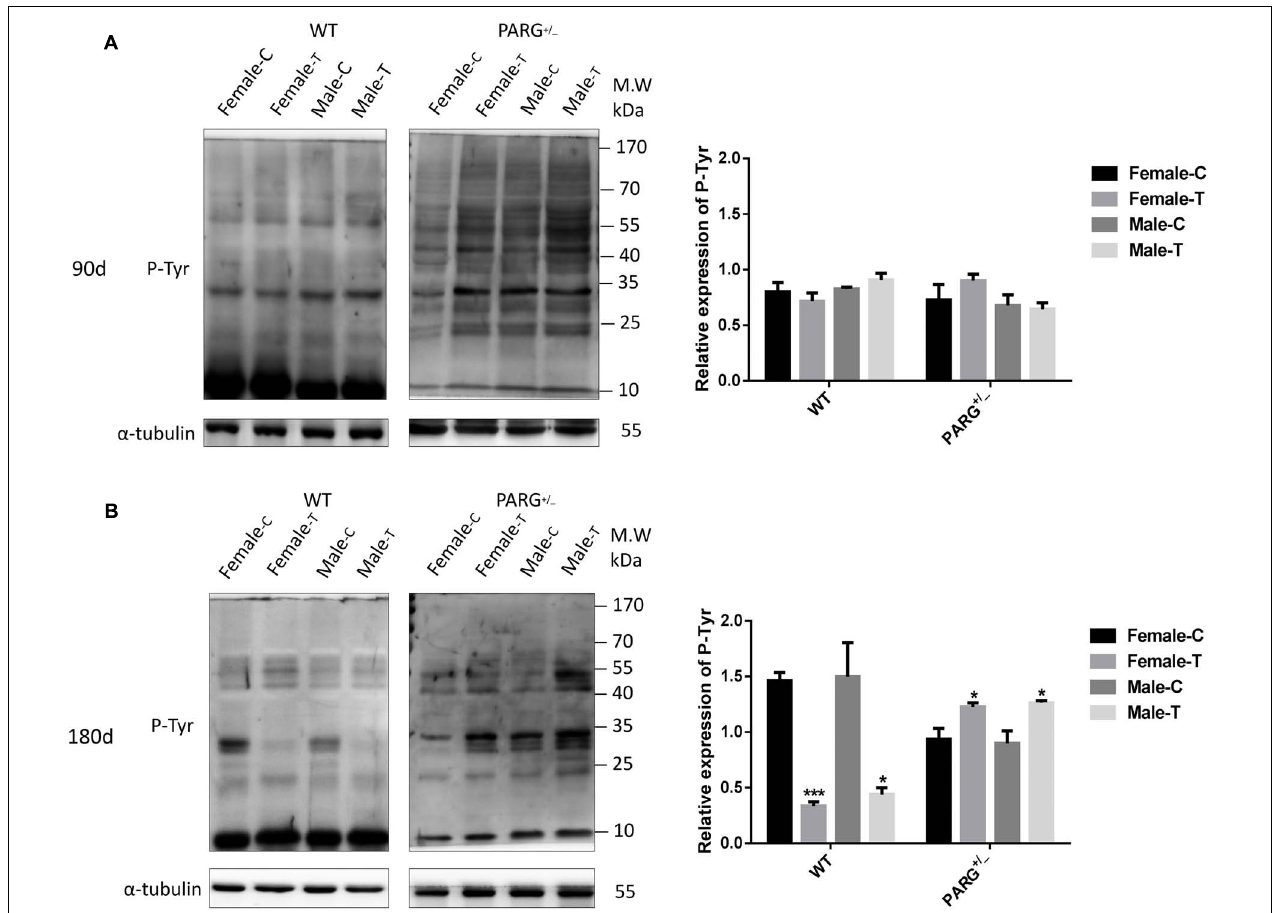
FIGURE 3 | PARG + / − mice express elevated levels of phosphorylated proteins in lung tissues after BaP inhalation exposure. Expression of phosphorylated proteins in lung tissues of mice after BaP inhalation exposure. (A) The overall phosphorylation level of proteins in WT and PARG + / − mice that were untreated or were treated with exposure to BaP for 90 days. (B) Expression of phosphorylated proteins after 180-day exposure to BaP. Female-C, control untreated female mice; Female-T, treated female mice; Male-C, control untreated male mice; Male-T, treated male mice. ∗ P < 0.05, ∗∗∗ P < 0.001, significant difference in treated compared to untreated mice. Results represent the mean ± SD of 3 mice from each group. Quantification of the phosphorylation levels was performed using ImageJ